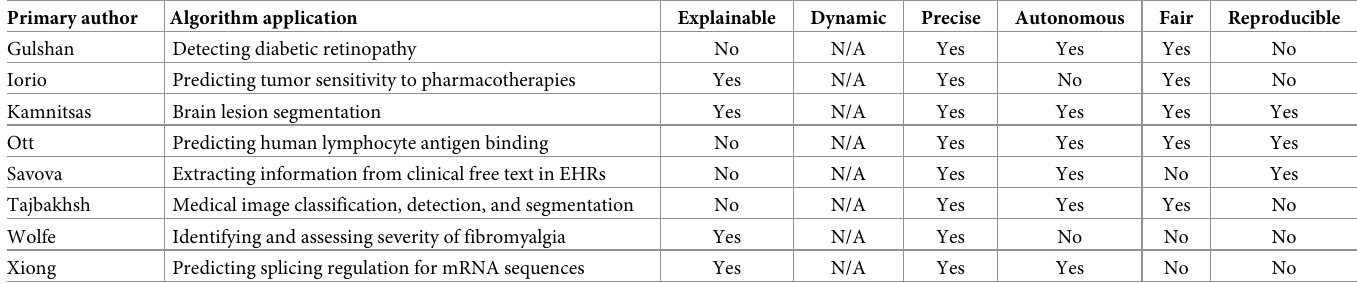
Table 2. Highly cited AI algorithms graded by their interpretability, dynamicity, precision, autonomy, fairness, and